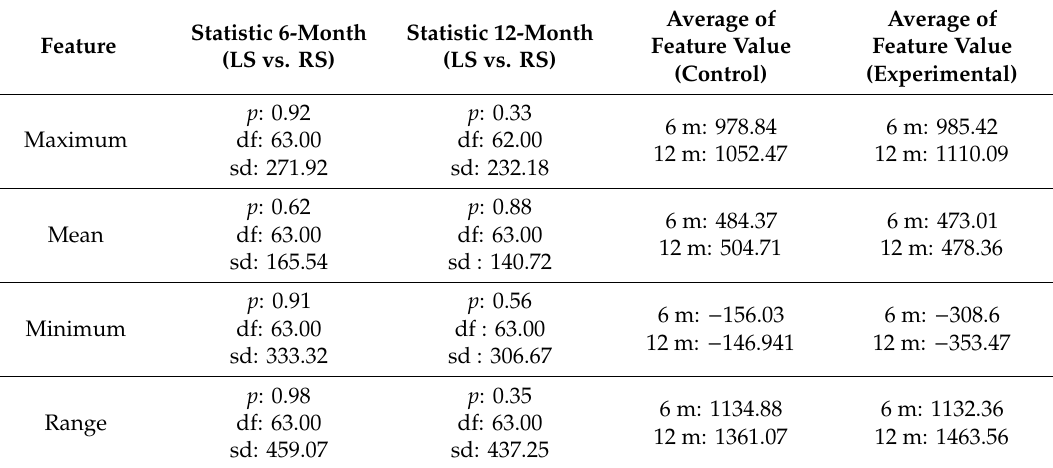
Figure 6. Maximum ( A ) and mean feature ( B ) values extracted from the axial plane of spine CT. The left and right sides are represented by red and green bars. The middle line is the mean value, the bar is the standard deviation, and the points are the feature values. The maximum is the largest Housfield unit (HU) value, and the mean is the average gray level intensity inside the region of interest (ROI). Table 3. The result of radiomic feature analysis.